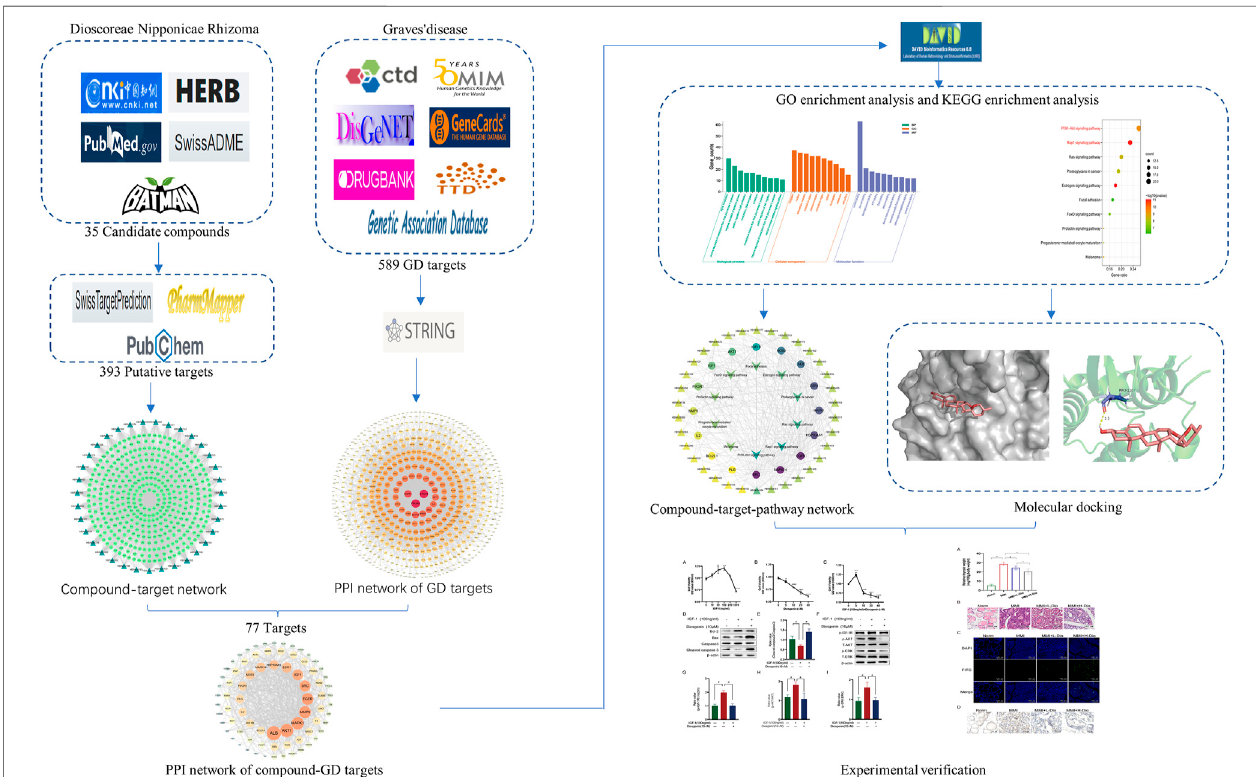
FIGURE 1 | Work fl ow for investigating the mechanism of DNR in GD treatment.